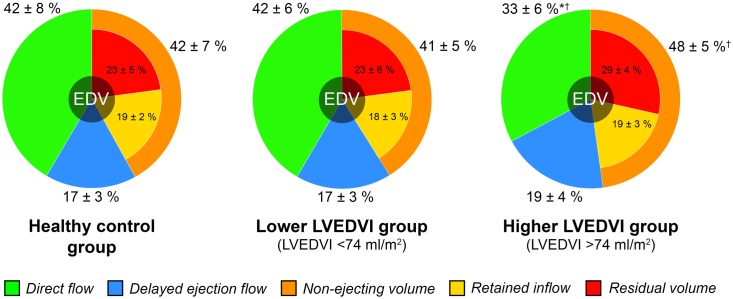
The 4D flow components as proportions of total LV EDV (percent ± SD) in the three sub-groups stratified by LVEDVI.Non-ejecting volume is comprised of the Retained inflow (yellow) and Residual volume (red) flow components (yellow + red = orange). * P<0.05 vs Control group; † P<0.05 vs Lower LVEDVI group.